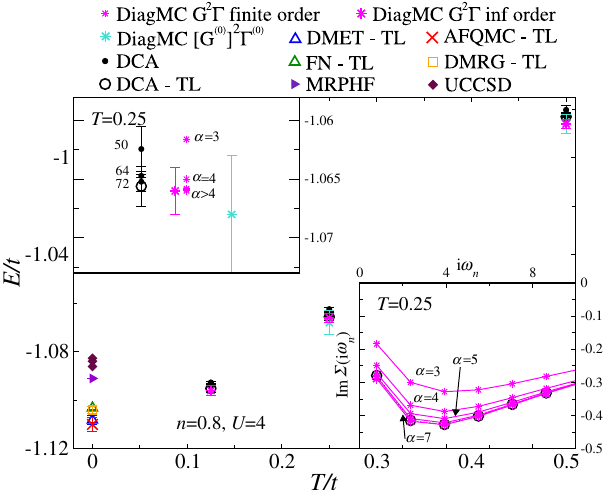
FIG. 11. Data for n ¼ 0 . 8 for U=t ¼ 4 . Main panel: Temper- ature dependence of E=t compiled from various techniques. Solid symbols represent finite systems; open symbols represent extrap- olations to the thermodynamic limit. Finite- T results are shown for DCA (black circles) and DiagMC (pink and turquoise asterisks), and zero- T data from AFQMC (red crosses), DMRG (orange squares), FN (green triangles), and DMET (blue trian- gles). Top left inset: Zoom-in of the T=t ¼ 0 . 25 data from DCA and two types of DiagMC for different orders α ¼ 3 ; 4 ; … . Bottom right inset: Plot of the imaginary part of the local self- energy Im Σ ð i ω n Þ from DiagMC for different expansion orders α and from DCA (black circles covered by magenta stars).